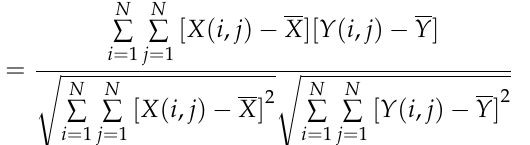
9. After calculating the center points and maximum widths of the k f fringe patterns, we can reconstruct k f fringe patterns separately. For the cases of the fringe patterns with only 180 ◦ phase difference, the reconstructed signals, s k 1 , and s k 2 (from the signal s k 1 ) are generated by using Equation (3) with ϕ 0 = 0 o and ϕ 0 = π , respectively; 10. The correlation coefficients (CCs) between the original and reconstructed signals, s k 1 , and s k 2 , are denoted as cor k 1 and cor k 2 for all the k f reconstructed fringe patterns, respectively. The CC value r between the two 2-D fringe patterns X ( i , j ) and Y ( i , j ) of size N by N is defined in Equation (12), which is used to measure the similarity between the reconstructed and original signals.